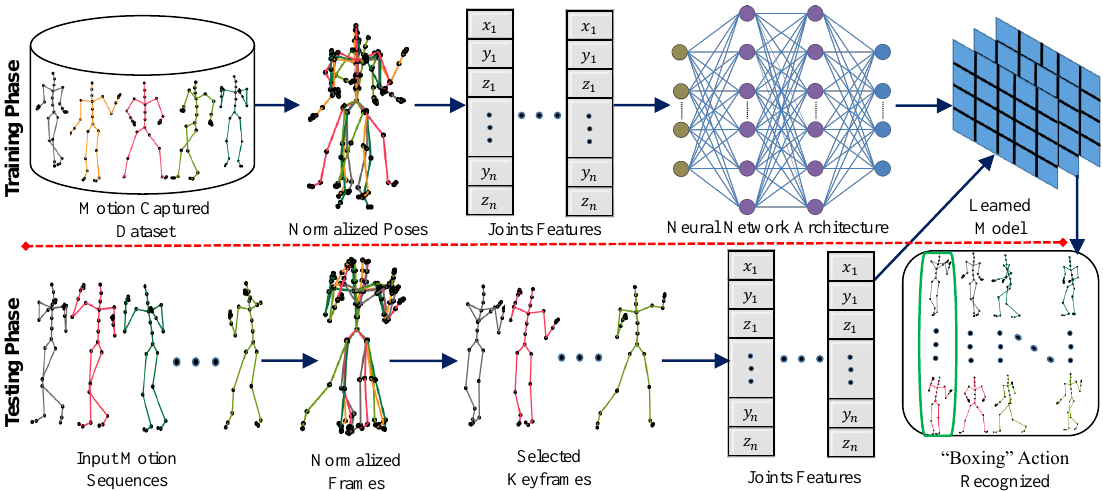
Figure 1. System overview. The first phase is the training phase , while the second phase represents the testing phase . In the training phase , 3D poses are normalized first by removing orientation and translational information from each pose, thus developing the normalized pose space. The joint features are extracted from these normalized poses and are given as input to the deep neural network in order to learn the model. The testing phase includes normalization, keyframe extraction and then the extraction of joint features, on the basis of which the action is recognized with the help of the learned